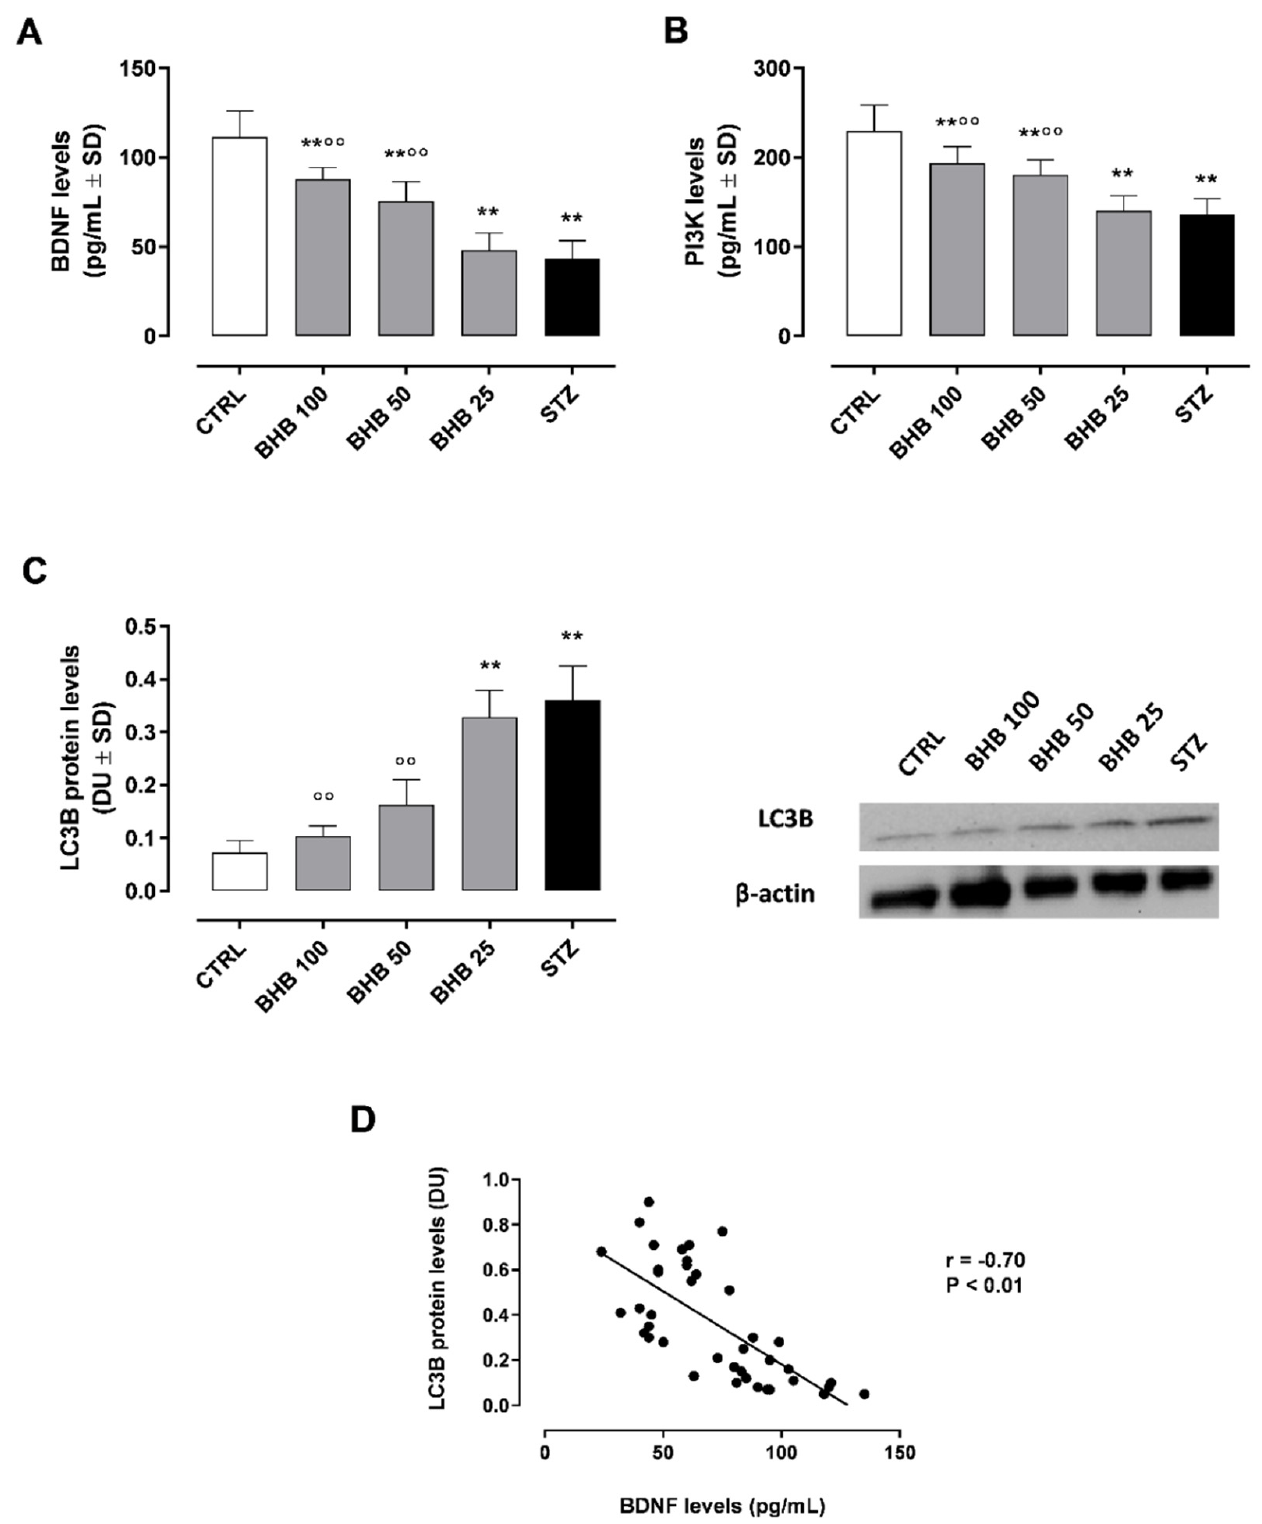
Figure 1. Retinal levels of BDNF ( A ), PI3K ( B ), LC3B ( C ), and strength of association between BDNF and LC3B ( D ) in non-diabetic mice (CTRL), diabetic mice (STZ), and diabetic mice treated with BHB 25 mg/kg (BHB 25), 50 mg/kg (BHB 50), and 100 mg/kg (BHB 100). BDNF (pg/mL) and LC3B (densitometric units, DU) levels are expressed as mean ± SD of N = 8 retinas per group. ** p < 0.01 vs. CTRL; °° p < 0.01 vs. STZ. BDNF levels were significantly restored by intraperitoneal (i.p.) BHB at the doses of